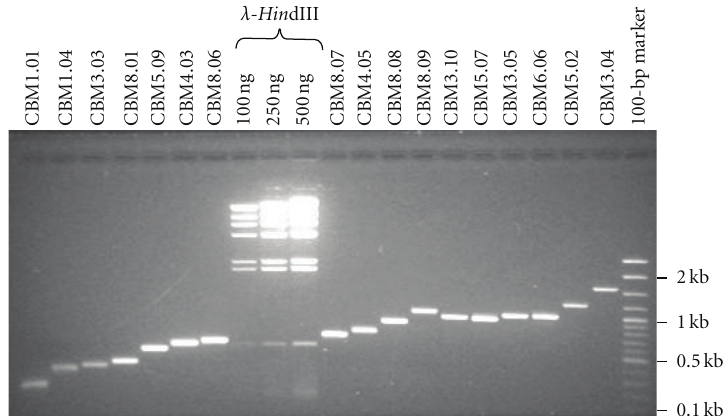
Figure 1: EtBr-stained agarose gel of CBM inserts. PCR amplification products for individual prepared CBM RFLP probes (indicated above the lanes), loaded from left to right in order of their predicted size. Mass standards ( Hin dIII-digested λ DNA) are labeled, and the total amounts loaded appear above the lanes. Size standards (100-bp marker) are included, and selected band sizes are indicated at right.